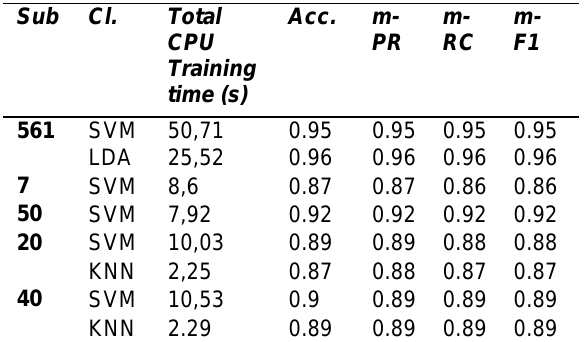
TABLE 2: Comparative results: